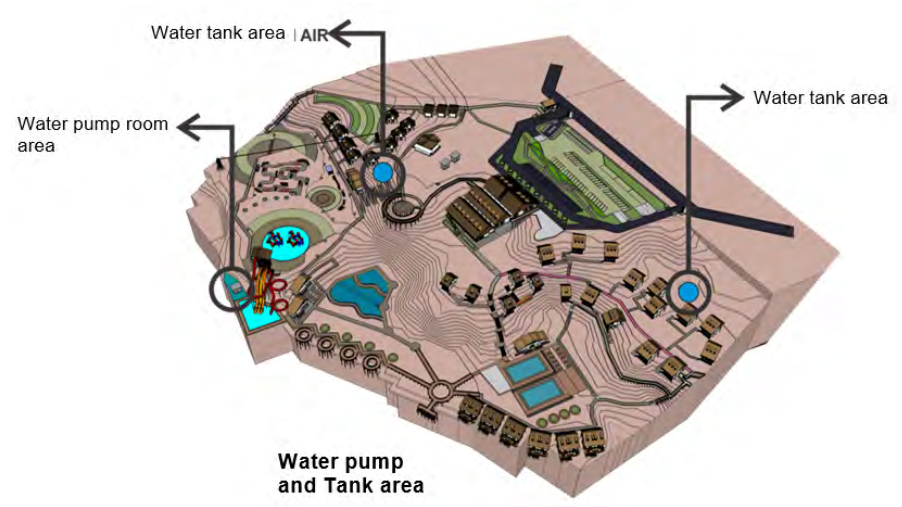
Figure 4. Location of water tank positioning